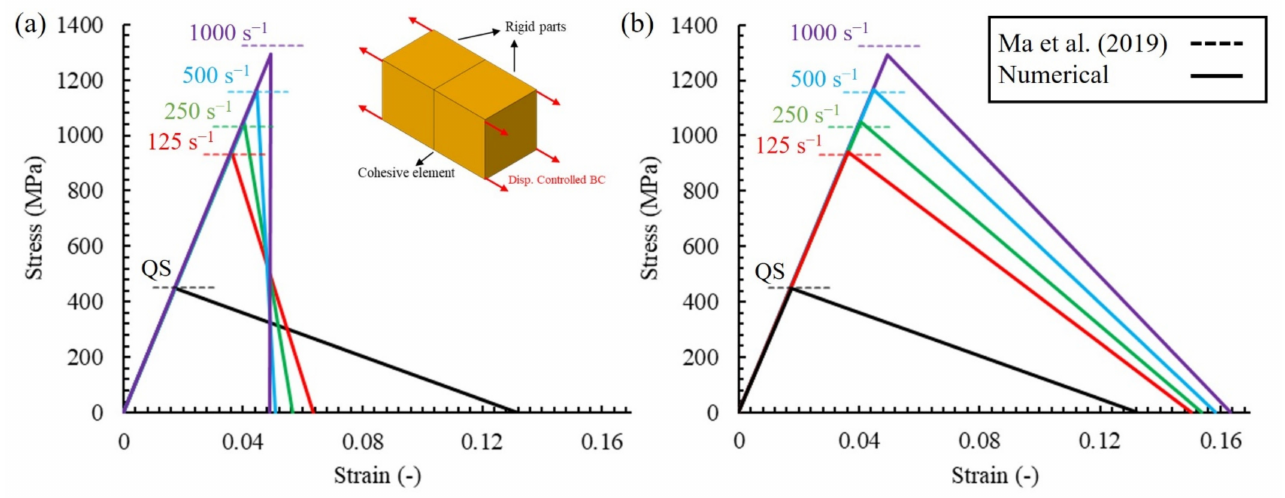
Figure 6. Comparison of the simple tensile loading results at different strain rates with mesoscale simulation results of [38]: ( a ) CE model, ( b ) CD model. Drawn on the basis of the data from